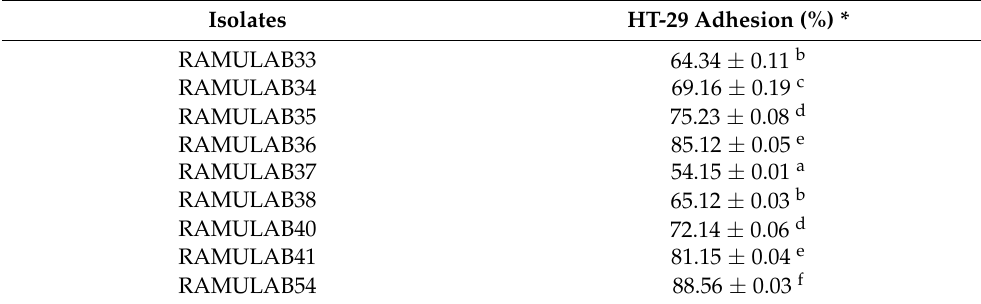
Figure 3. Under a light microscope, LAB strain adherence to buccal epithelial cells has been observed. The buccal epithelial cells in ( A ) are the control, and the isolates’ ( B ) RAMULAB33, ( C ) RAMULAB34, ( D ) RAMULAB35, ( E ) RAMULAB36, ( F ) RAMULAB37, ( G ) RAMULAB38, ( H ) RAMULAB40, ( I ) RAMULAB41 and ( J ) RAMULAB54 adhesion to these cells is shown. The arrow points to the isolates that are attached to the epithelial cells. Table 5. HT-29 cells adhesion assay of isolates from fermented sugarcane